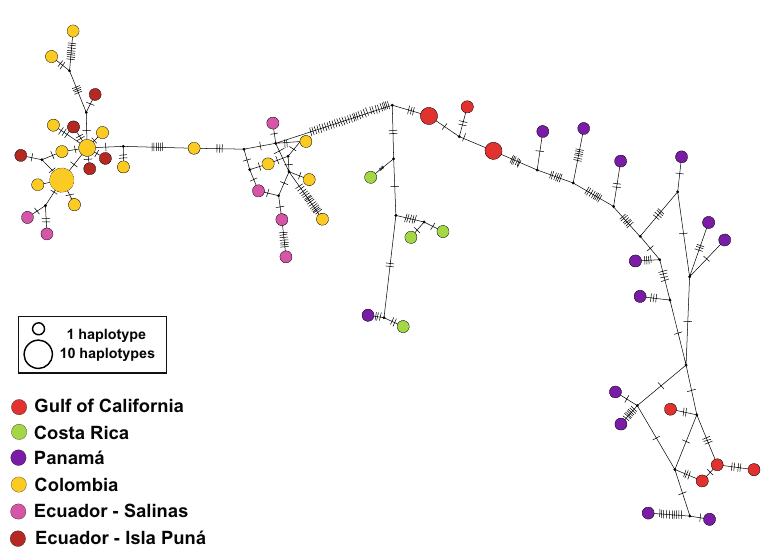
Figure 5. Median-Joining network of the East Pacific clade of Petrolisthes armatus , based on concatenated haplotypes of 16S and two regions of COI. Notation as in Fig. 3.